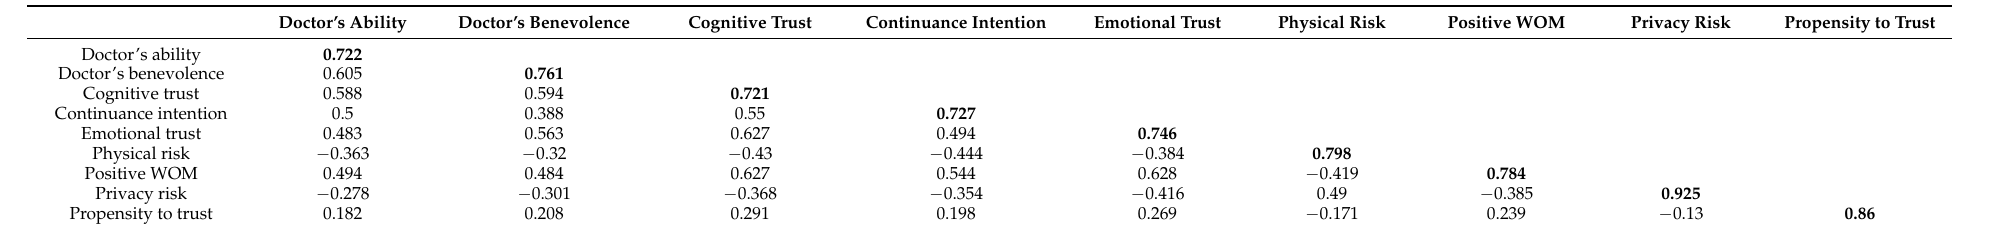
Table 5. Results of discriminant validity (Fornell and Larcker criterion).